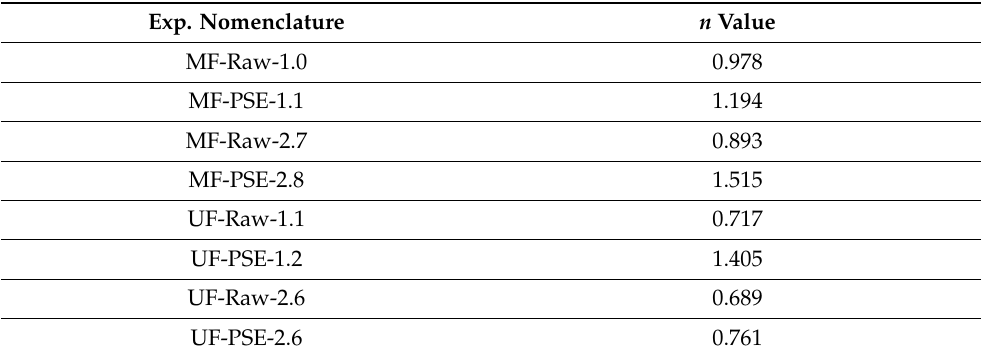
Table 5. Results of the general fouling model (Equation (1)) for the hourly (MF membrane) and daily (UF membrane) TMP